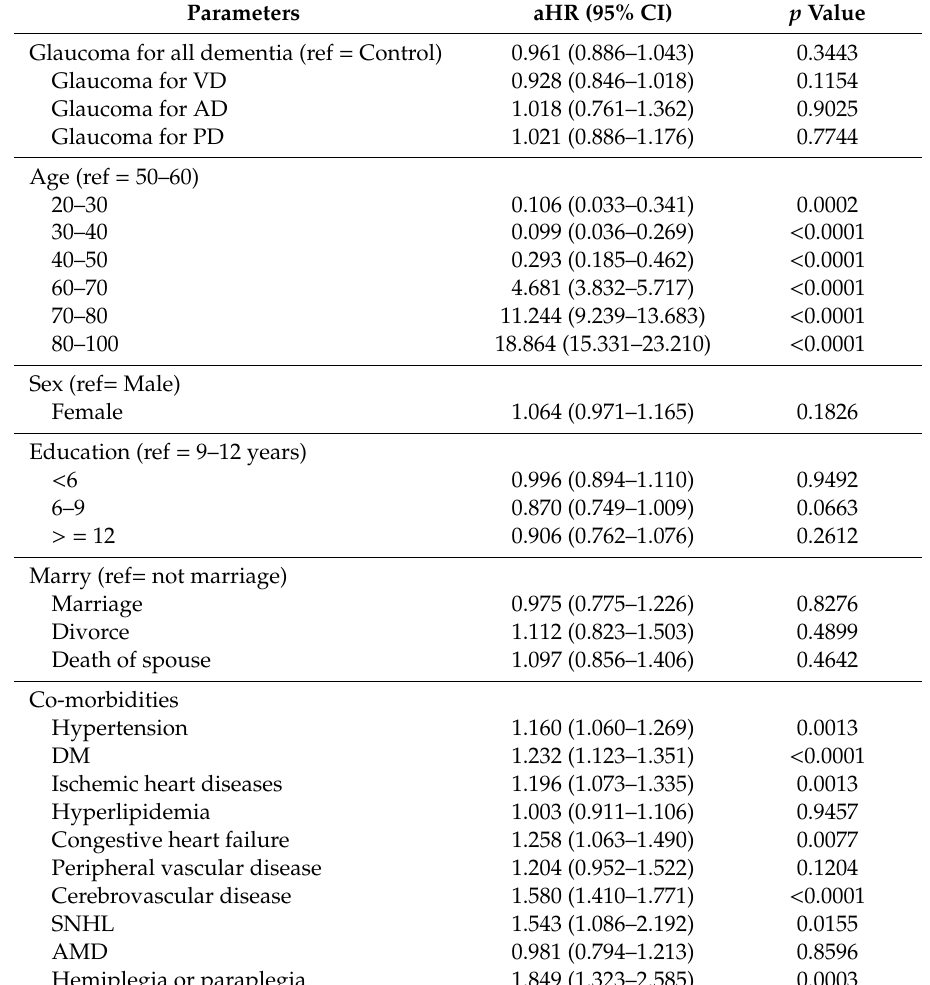
Table 3. Cox regression for estimates of the adjusted hazard ratios of